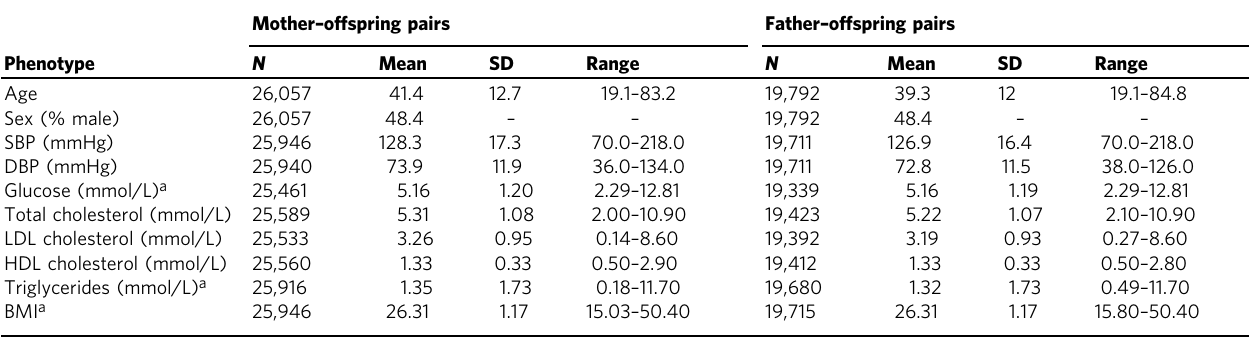
Table 3 Descriptive statistics for offspring cardiometabolic risk factors in the primary analyses. Mother – offspring pairs Father – offspring